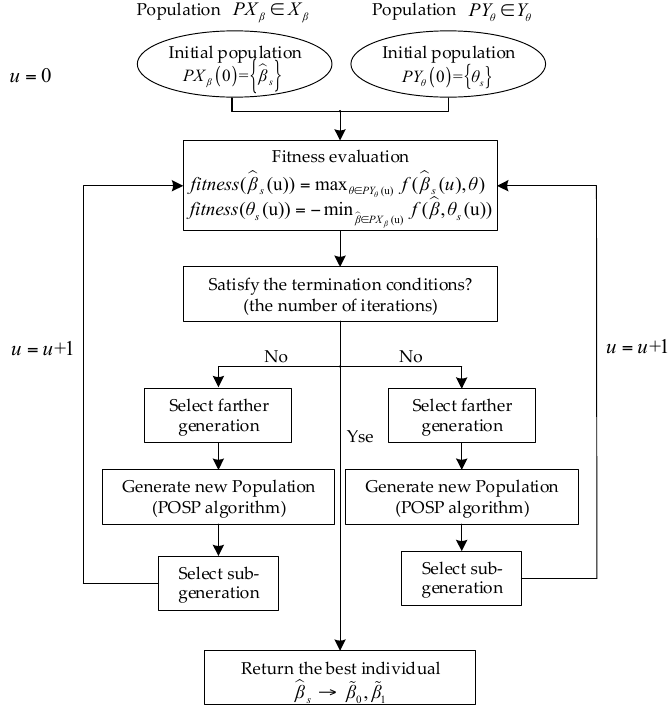
Figure 5. The flowchart of solving fitting coefficients using the two-population coevolutionary algorithm.